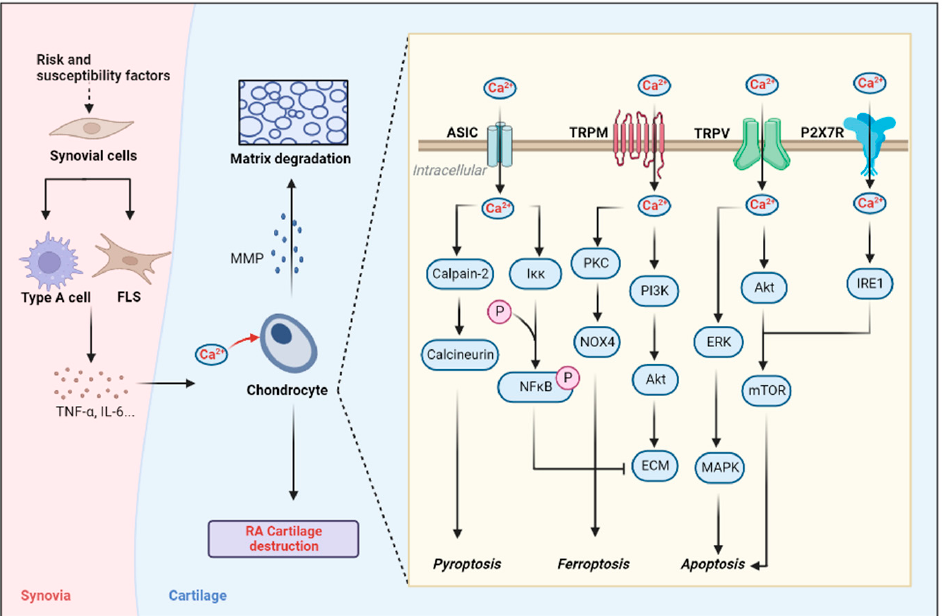
Figure 3. Role of calcium-permeable channel in cartilage destruction. Stimulated synovial cells can promote chondrocyte apoptosis by secreting inflammatory factors. At the same time, a large influx of calcium ions in chondrocytes triggers the activation of intracellular calcium ion signaling pathways (NF- κ B pathway, PI3K-Akt pathway, etc.). This eventually leads to the degradation of cartilage matrix and apoptosis, pyroptosis and ferroptosis of chondrocytes (created with Bioren- der.com).